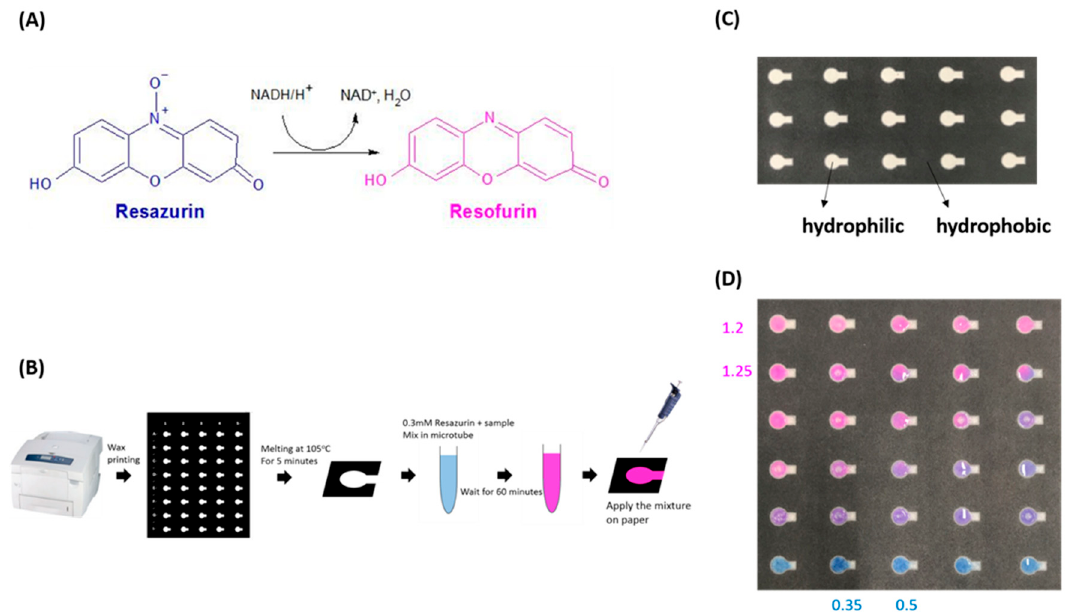
Figure 1. ( A ) Molecular structure of resazurin chemistry; ( B ) paper-based device preparation and resazurin assay methods; ( C ) the test pattern of the paper-based device; ( D ) a demonstration of color differences of the applied mixture of resazurin and semen on the paper-based device. Values in this figure are calculated red and blue color intensities (RBCIs) for test zones.